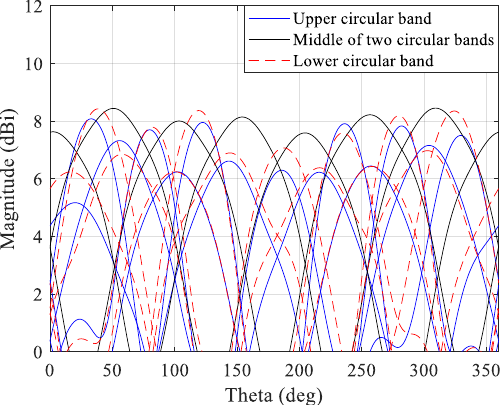
Figure 6. Different radiation pattern obtained by the 3D antenna array.